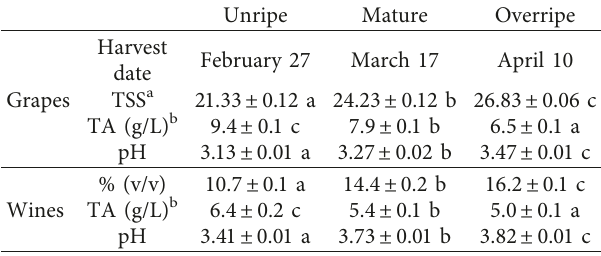
Table 1: Maturity controls of the grapes used for winemaking: general parameters of the finished